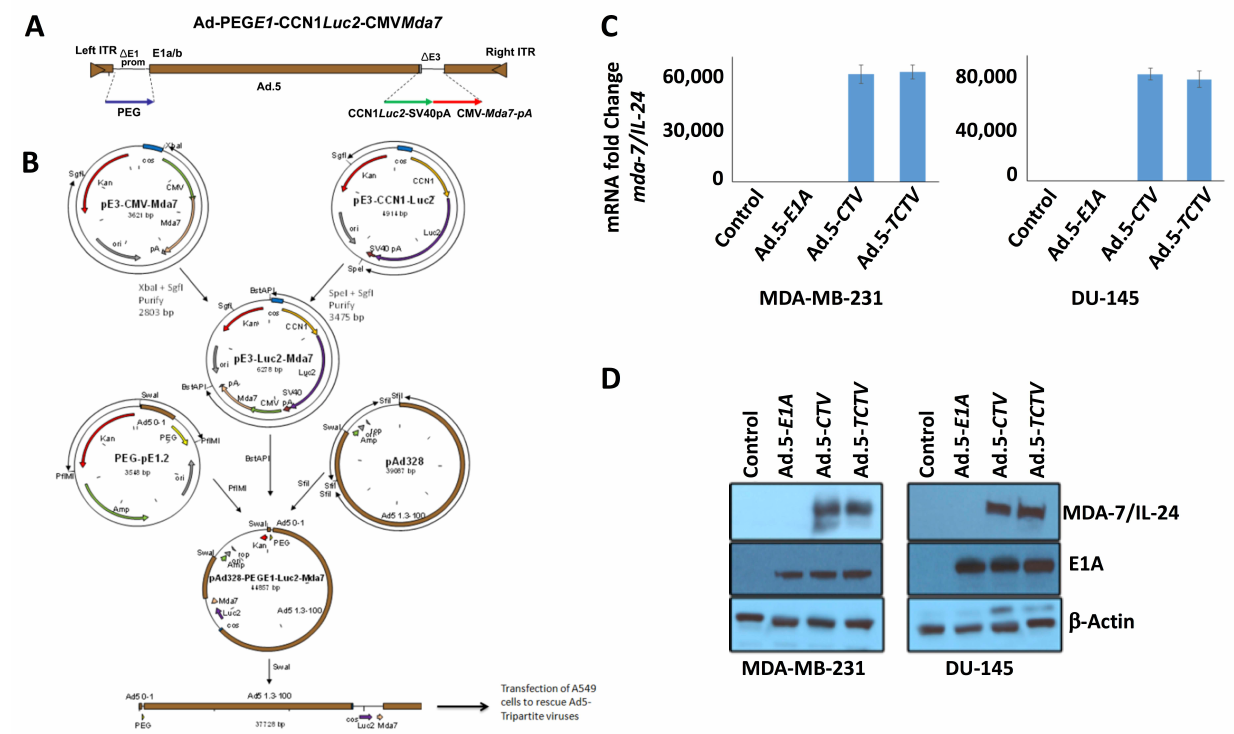
Figure 1. Construction and characterization of Ad.5- TCTV . ( A ) Schematic diagram representing the gene sequence in the vector used to generate the TCTV . A truncated PEG -Prom drives type 5 adenovirus replication and a truncated tCCN1 -Prom drives luciferase expression. ( B ) Schematic representation of the cloning procedure used to construct the Ad.5- TCTV . ( C ) MDA-MB-231 and DU-145 cells were infected with either Ad.5- E1A (25 pfu), Ad.5- CTV (25 pfu), or Ad.5- TCTV (25 pfu) for 48 h. Total RNA was extracted using Trizol reagent, and reverse transcriptase PCR was performed for assessment of mda-7/IL-24 mRNA transcript levels. GAPDH served as a loading control. ( D ) Western blotting for E1A and MDA-7/IL-24 protein expression was done using cell lysates with specific